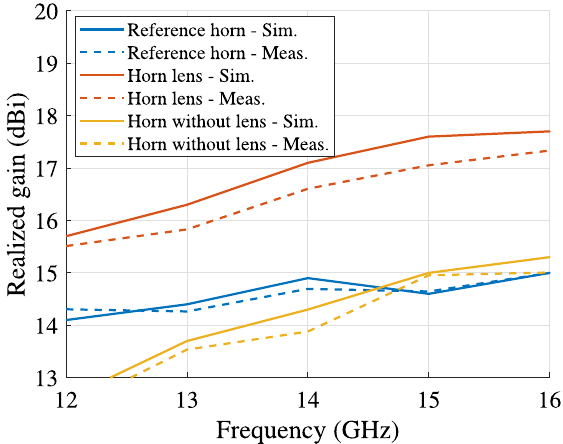
Figure 11. Simulated and measured realized gain for the horn lens antenna, profiled horn antenna without lens, and the reference horn antenna. The dimensions are L L = L H = 207 mm, W L = W H = 167 mm, H L = H H = 20 mm, and F L = 40